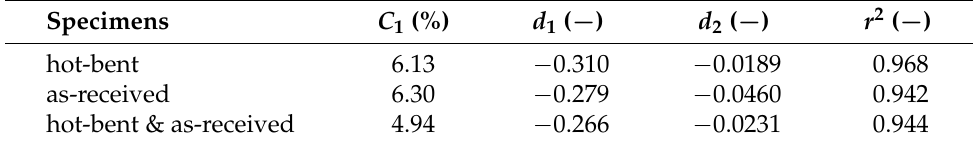
Table 5. Determined material values C 1 , d 1 , and d 2 for the hot-bent material, the as-received ma- terial, and the combination of the hot-bent and as-received material. In addition, the coefficient of determination r 2 is given to estimate the quality of the